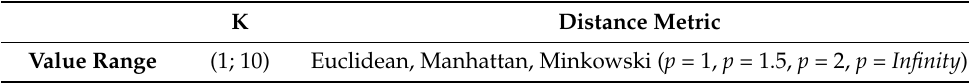
Table 10. Hyperparameters of the KNN